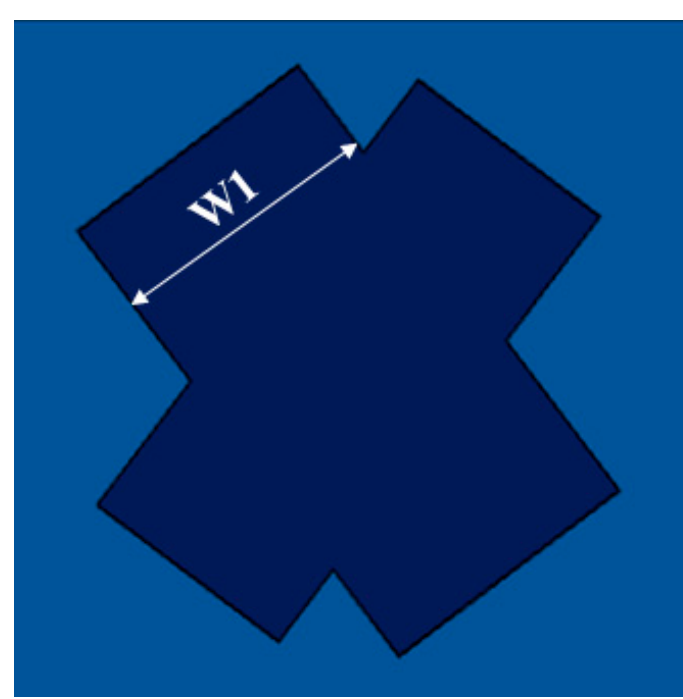
Figure 7. Asymmetric X shaped nanostructure. Table 1. Asymmetric